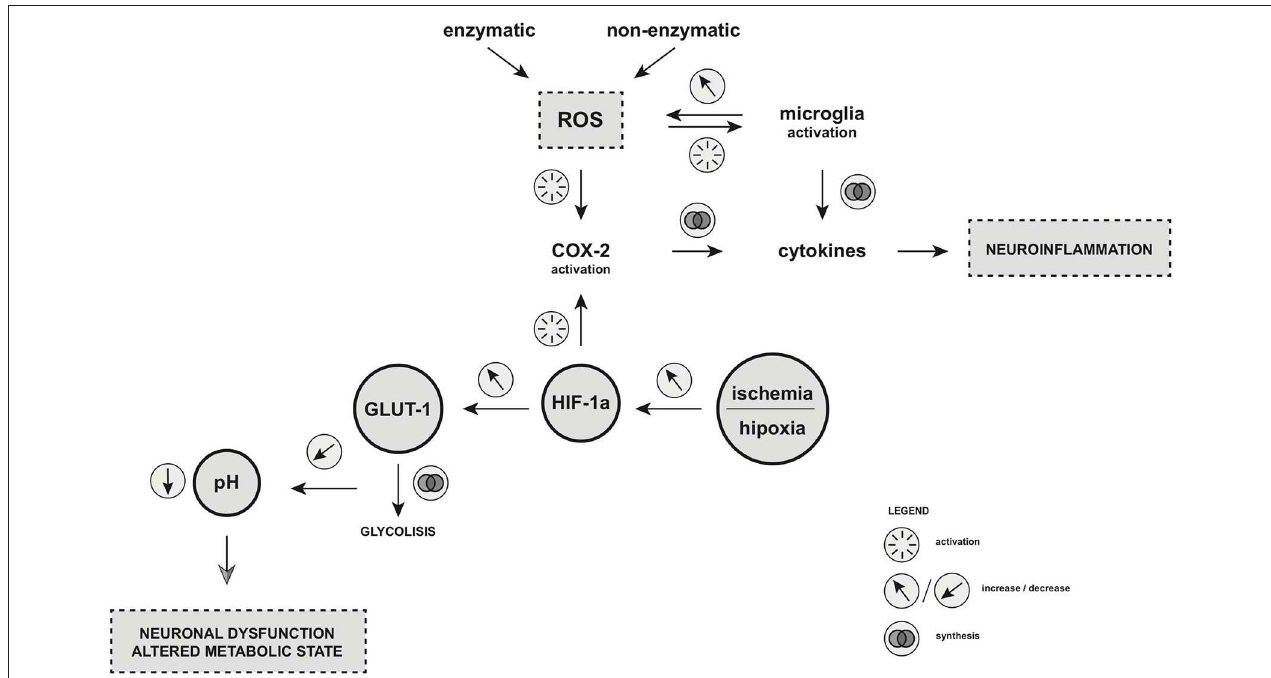
FIGURE 1 | Oxidative stress and hypoxia as the key players of epileptogenesis. Enzymatic and non-enzymatic pathway of ROS production as well as increased level of HIF-1 α under hypoxic/ischemic condition leads to COX-2 activation. As the result, microglia is activated and cytokines production is augmented, which leads to neuroinflammation. HIF-1 α is also the factor that regulates the glucose metabolism in the central nervous system (CNS) through GLUT-1 synthesis. Dysregulation of HIF-1a production may result in an accumulation of pyruvate in neuronal cells which is then converted into butyric acid via butyric dehydrogenase. This accumulation of by-products may lead to a decreased pH within the inner environment of neuron, leading to its dysfunction and altered metabolic state. ROS, reactive oxygen species; COX-2, cyclooxygenase-2; HIF-1 α , hypoxia inducible factor-1 alpha; GLUT-1, glucose transporter-1. Illustration by Paulina